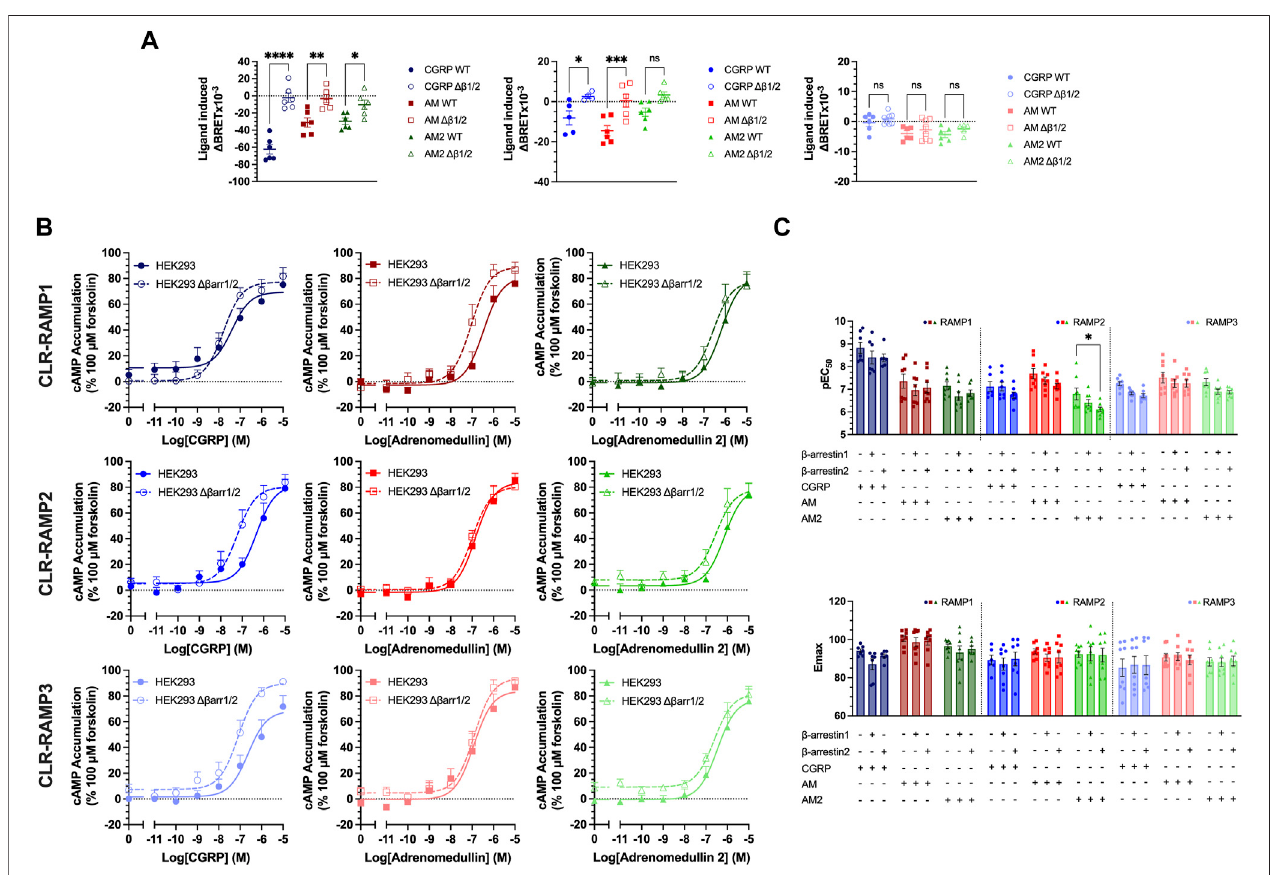
FIGURE4| Expressionof β -arrestinsreducedpotencyandef fi cacyofcAMPsignallingforallCLR-RAMPcomplexes. (A) ChangesinCLRinternalisationincomplex withRAMP1,RAMP2,orRAMP3inHEK293cellsexpressing(closedsymbols)orlacking(opensymbols) β -arrestin1/2.Statisticalsigni fi cancebetweenresponsesinWT and β -arrestin1/2 KO cells was determined, at p < 0.05, through Student ’ s t-test (*, p < 0.05; **, p < 0.01; ***, p < 0.001; ****, p < 0.0001). (B) Effect of knocking out β - arrestin1/2 on cAMP incells expressing CLR-RAMP1, RAMP2, orRAMP3. (C) Barcharts showingthe potency and maximalresponseofthepeptidesat CLR with each RAMP in turn, in cells overexpressing β -arrestin1 or 2. All data are mean ± SEM of n repeats where n ranges between 3 and 4 duplicates. Statistical signi fi cance of responses in the presence of overexpressed β -arrestins was compared to the response in the absence of β -arrestin, at p < 0.05, using a Two-Way ANOVA.